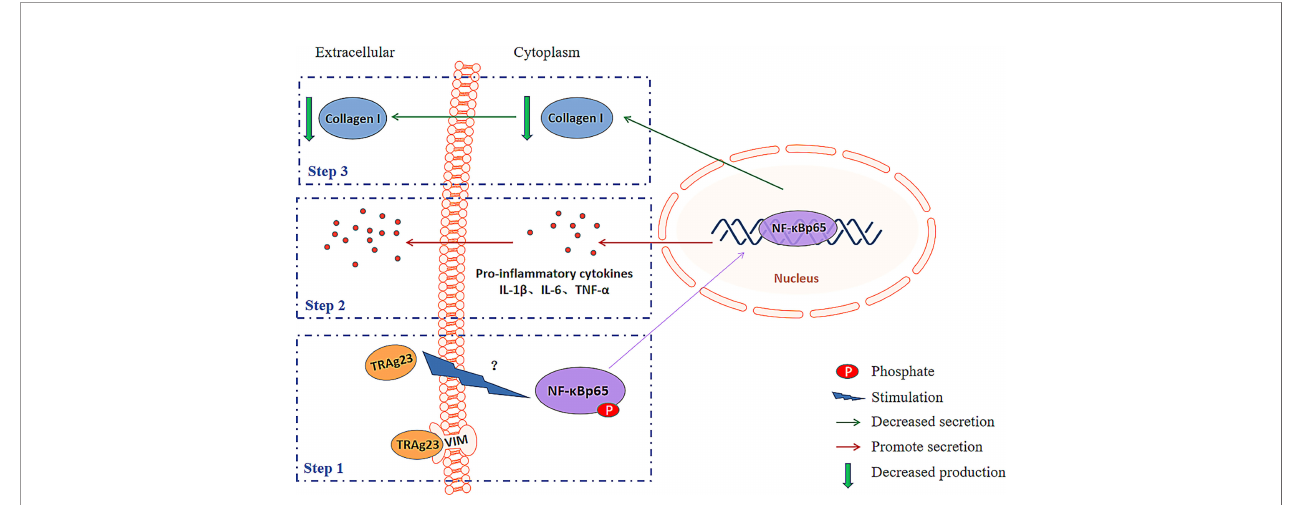
FIGURE 6 | Schematic diagram explaining the possible mechanism for the collagen-remodeling induced by PvTRAg23-stimulated